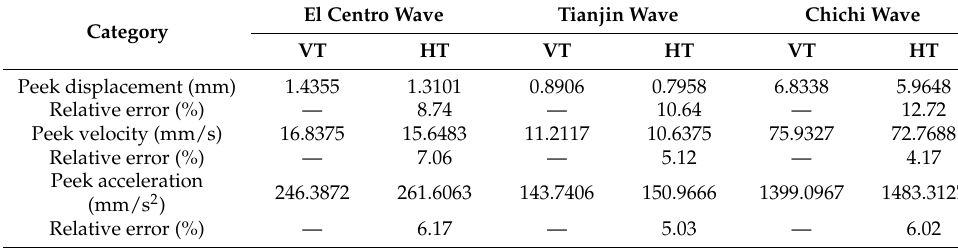
Table 4. Comparative analysis of Model C.